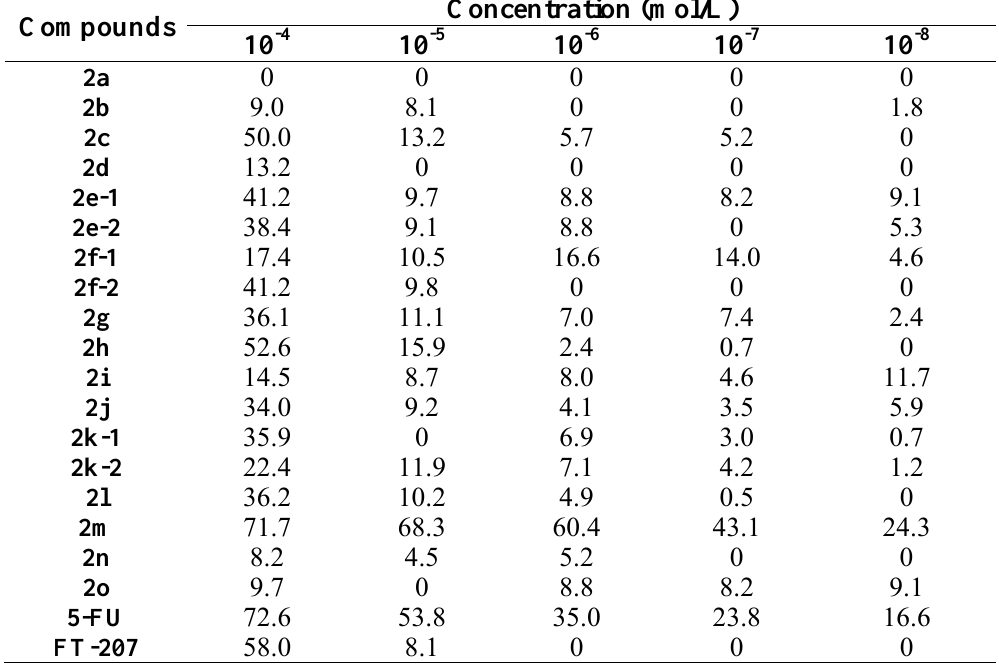
Table 2. Inhibitory rates (%) against